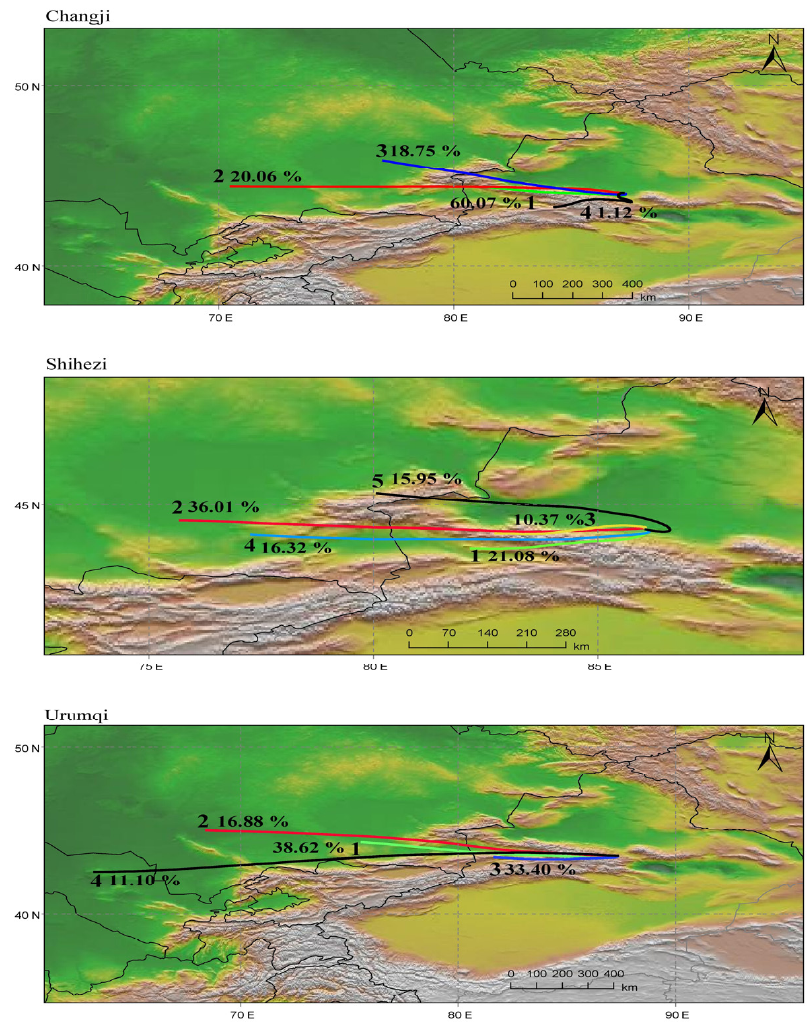
Figure 5. Clustering of backward trajectories of airflow in the Wu-Chang-Shi region during winter 2017–2021. Table 3. Statistical results of the mass concentration of all kinds of airflow in the four seasons of the Wu-Chang-Shi urban.